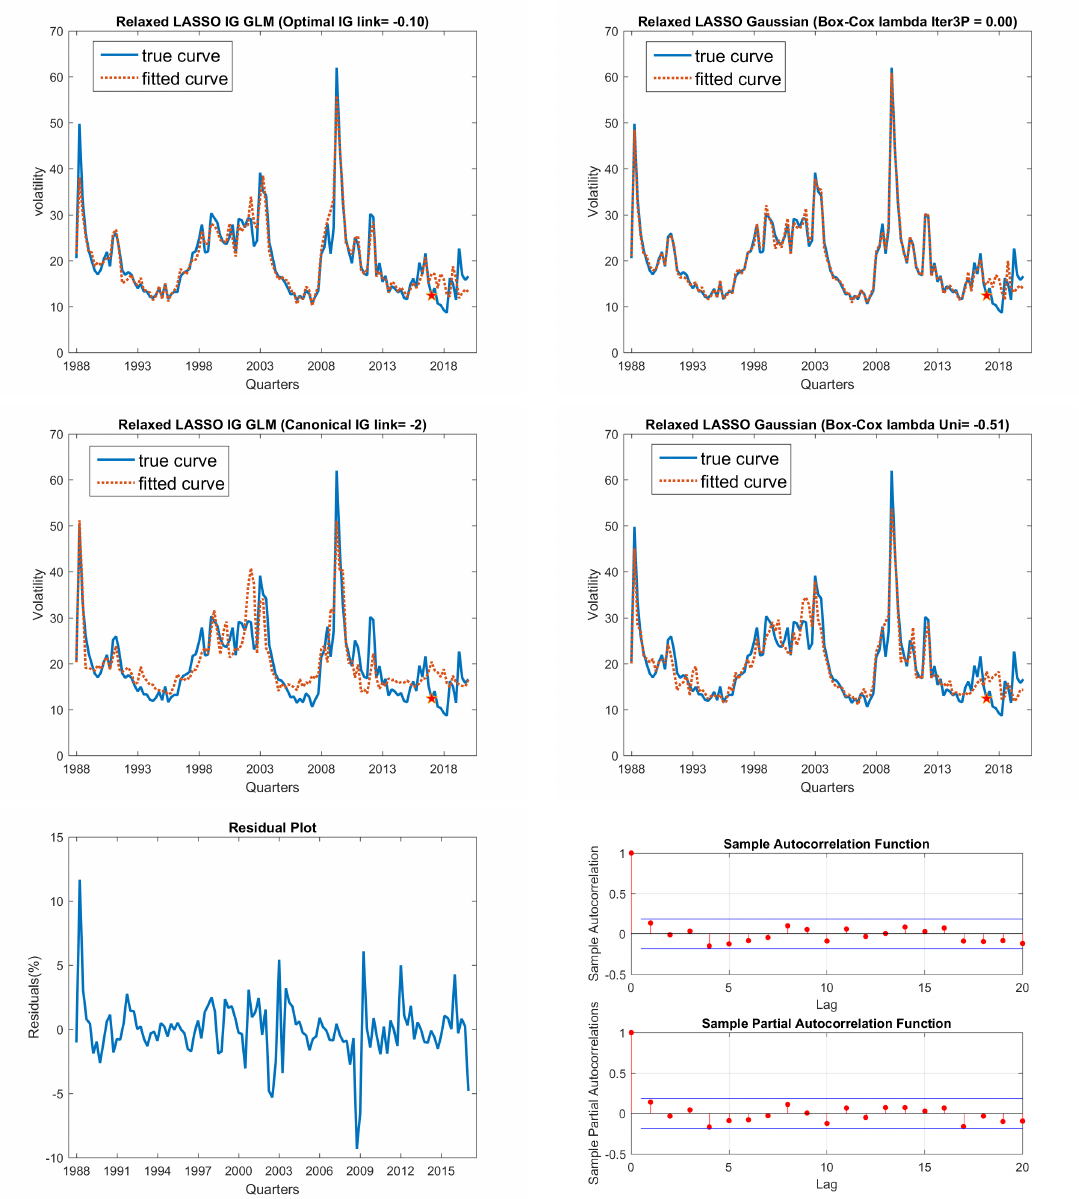
Figure 6. Fitted curve in comparison with true curve: VXO on macroeconomic data data. 1. ( Top-left panel ) is optimal link IG model; ( top-right panel ) is three-phase iteratively searched λ BC Gaussian model; 2. ( Middle-left panel ) is canonical link IG model; and ( middle-right panel ) is univariate λ BC Gaussian model; 3. ( Bottom-left panel ) is plot of residuals from best fitting model (optimal link IG model here); ( bottom-right panel ) is ACF and PACF plots to perform residuals serial correlation check, which shows no serial correlation. 4. VXO index fitting on macroeconomic data set using relaxed LASSO